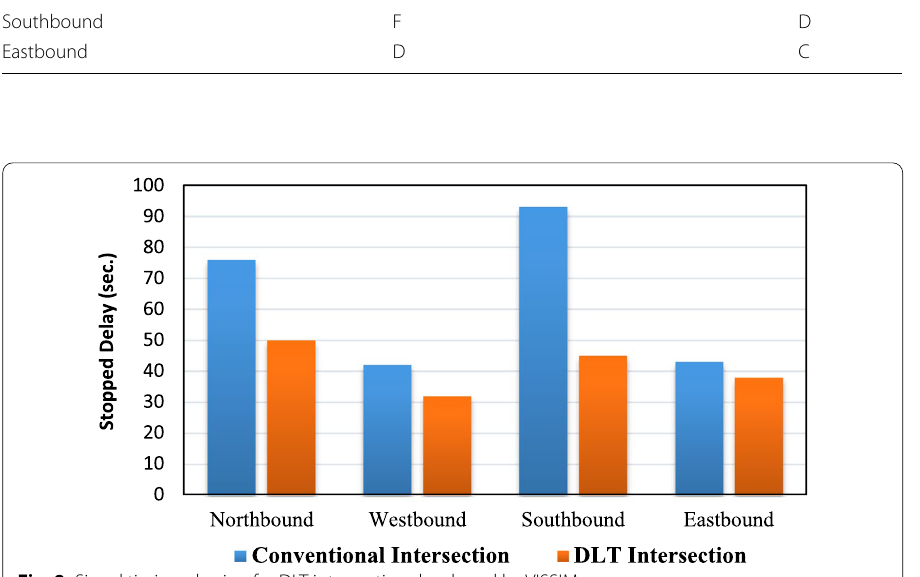
Fig. 8 Signal timing phasing for DLT intersection developed by